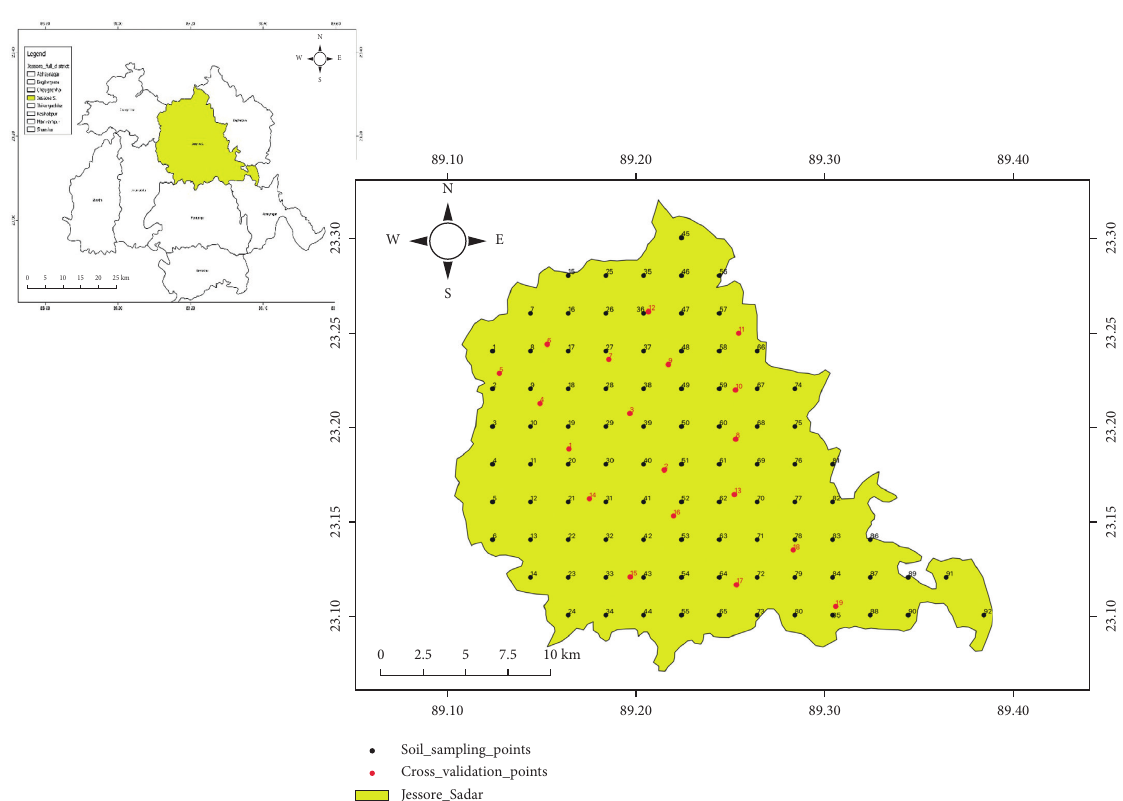
Figure 1: Map showing study area and soil sampling locations in the Jessore Sadar under different cropping patterns. Table 1: Descriptive statistics ( n =92) of soil chemical properties at the depth of 0–20cm.